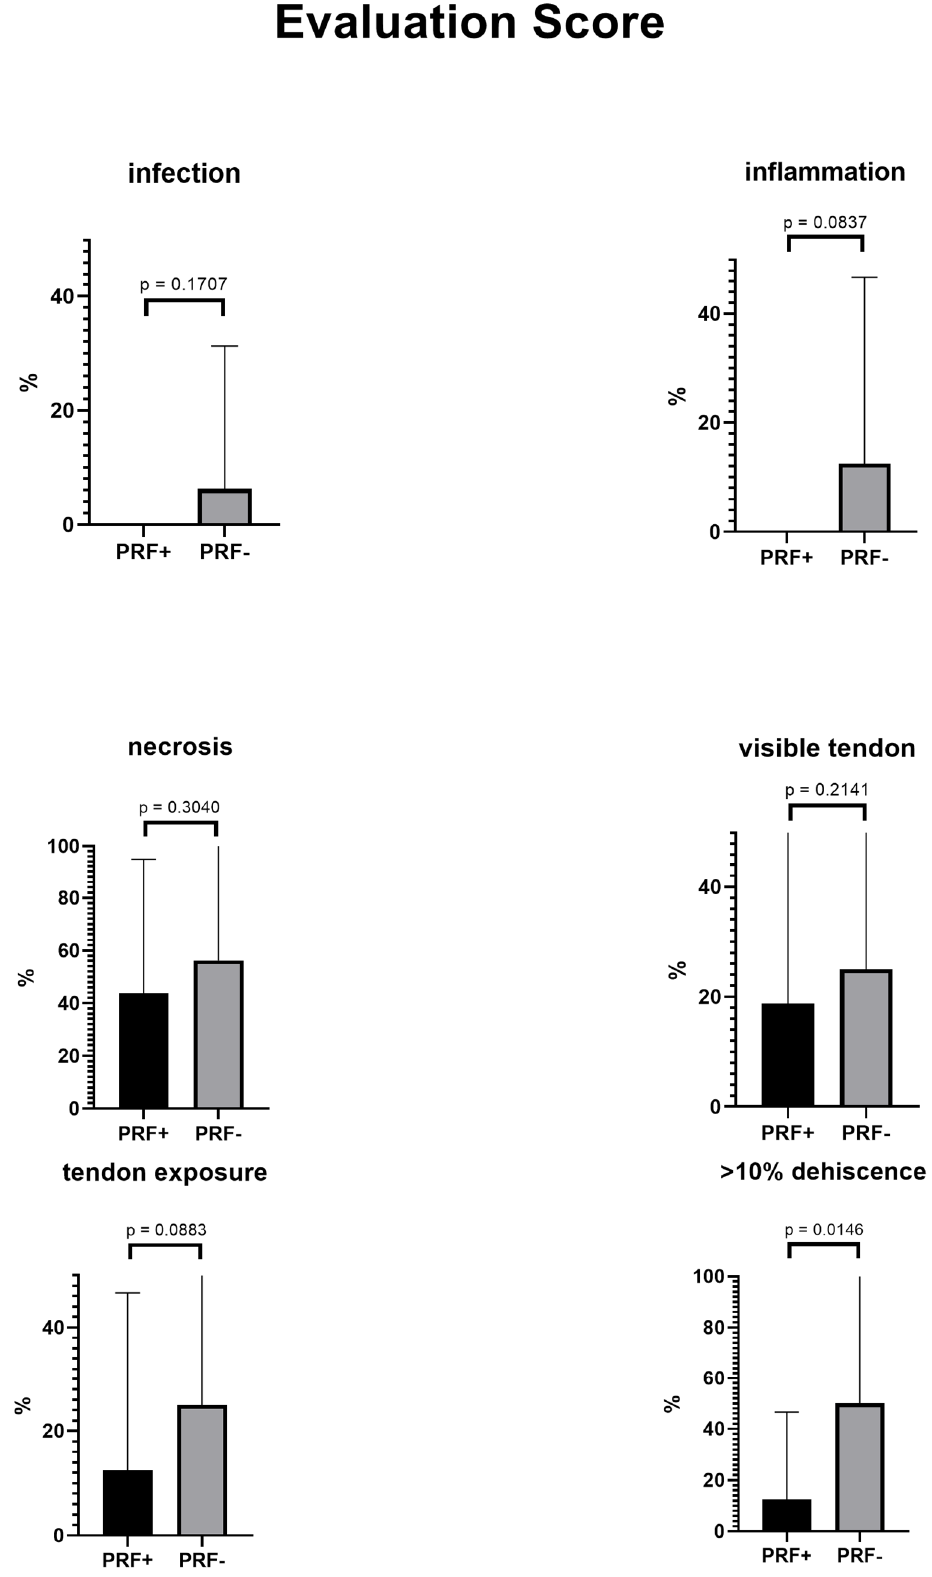
Figure 5. Evaluation score in the PRF group and in the non-PRF